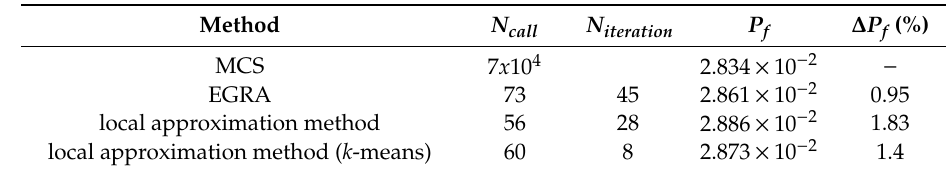
Table 5. Results of the reliability analysis of Example 3.